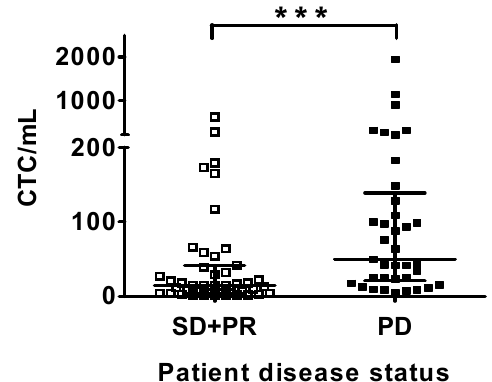
Figure 2. CTC counts for patients with progressive disease (PD), and patients with partial response (PR), or stable disease (SD). The disease status was determined at the time of blood collection for CTC counting. The CTC counts were plotted against the disease status of patients. A significant difference for the CTC counts was observed for the patients at the status of PR + SD and the patients at the status of PD. ***, p < 0.0001. Table 2. The testing results for circulating tumor cells (CTCs) and alpha-fetoprotein (AFP) and the disease status of patients with hepatocellular carcinoma (HCC).